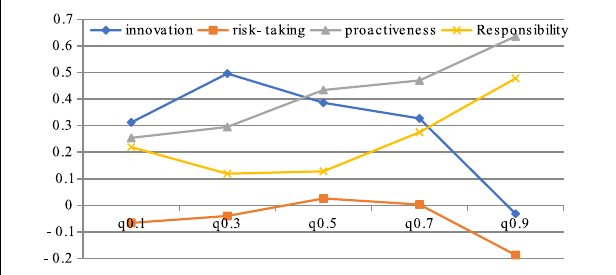
FIGURE 5 | Regression coefficient of quantile regression